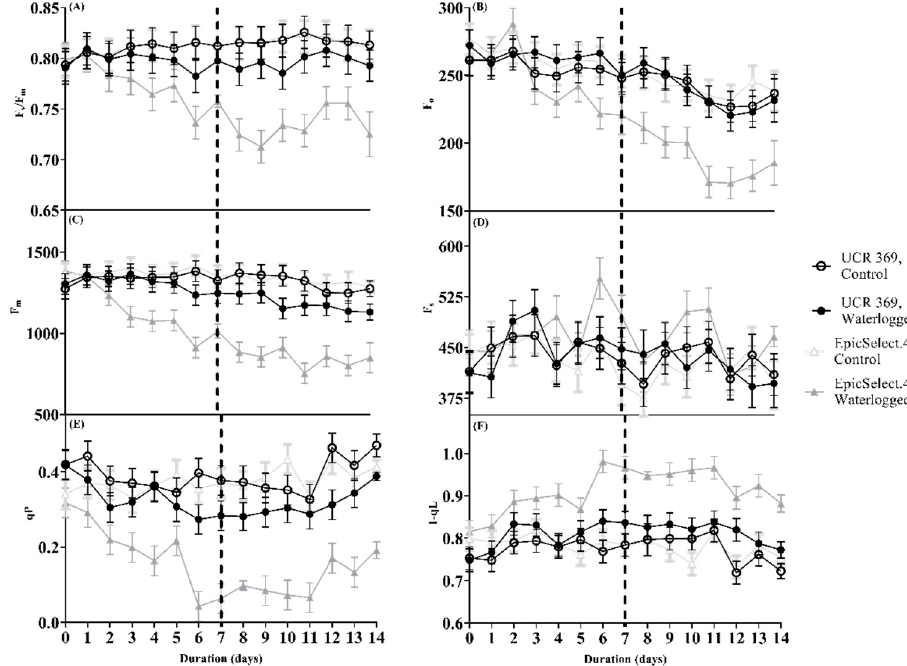
Figure 4. ( A ) Maximum quantum efficiency of PSII in dark-adapted state (F v /F m ), ( B ) Initial fluores- cence (F o ), ( C ) maximum fluorescence (F m ), ( D ) Steady-state fluorescence (F s ), ( E ) Redox state of the plastoquinone pool (qP), and ( F ) Redox State of Plastoquinone Pool Based on the Lake Model (1-qL) of control and waterlogged cowpea genotypes (UCR 369 and EpicSelect.4) during and after 7 days of treatment. The dashed vertical lines in ( A – F ) demarcated the waterlogging from the recovery period. The error bar on the line graph indicates the standard error of the mean ± 5 replications of each leaf gas exchange trait. Standard error of the mean, F v /F m = 0.16; F o = 11.50; F m = 63.30; F s = 30.81; qP = 0.39; 1-qL = 0.027.